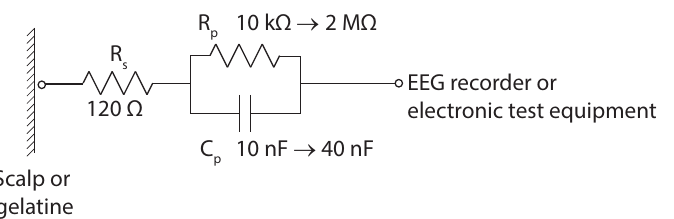
Figure 7. Wet silver/silver-chloride electrode model from [15]. R s is a series resistor modelling the bulk electrode impedance and the series component of the contact impedance, while R p and C p model the rest of the contact